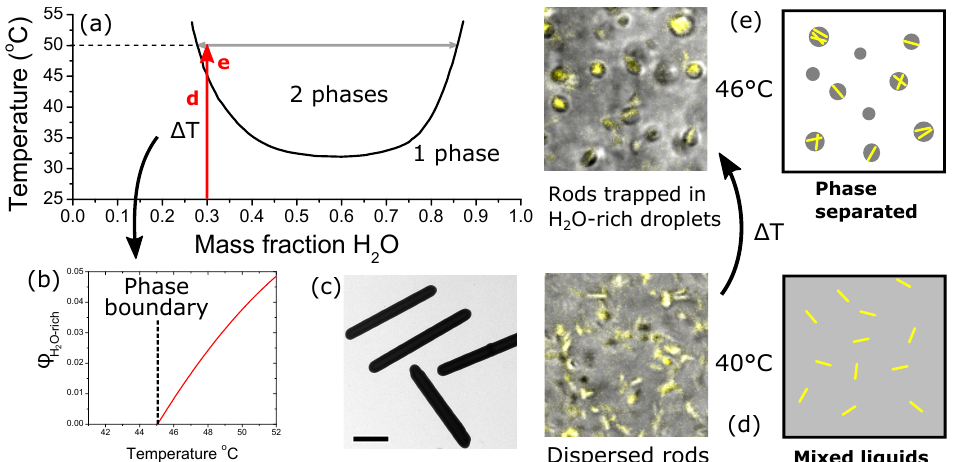
Figure 1. Showing how phase separating water and 1-propoxy-2-propanol can be used to create different phase volumes by controlling the depth of the temperature quench. ( a ) Our partially miscible solvents exhibit a lower critical solution temperature; ( b ) the temperature step into the demixed region can be used to control the volume of the minority phase, here the water-rich phase; ( c ) We use colloids shaped like sphero-cylinders, scale bar 1 µ m; ( d , e ) The colloids, shown in yellow, are dispersed at low temperature below the binodal line; see red d in ( a ), where the liquids are mixed. On warming the samples, the liquids demix and the colloids are confined within the minority phase; see red e in ( a